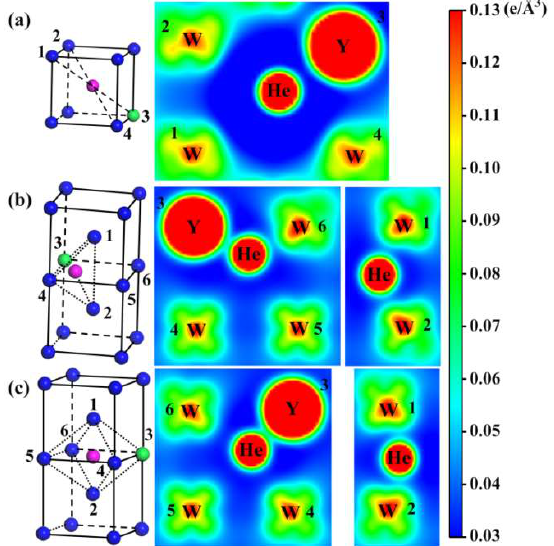
Figure 2. The charge density distribution of He in the bulk W-Y system. ( a – c ) correspond to He located at the Sub, TIS, and OIS, respectively. Here, blue, green, and purple balls represent W, Y, and He, respectively.